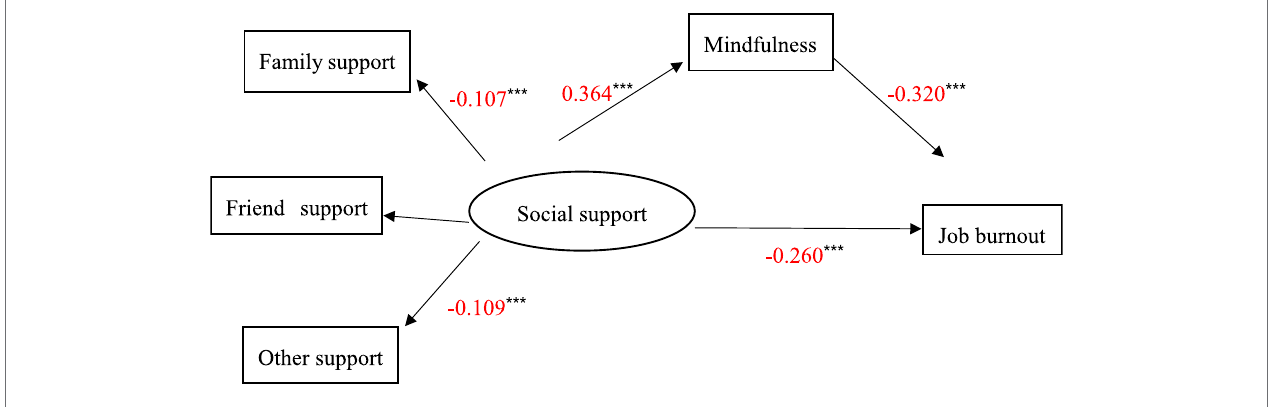
FIGURE 2 | Standardized estimates of social support, mindfulness, and job burnout. The *** means p <